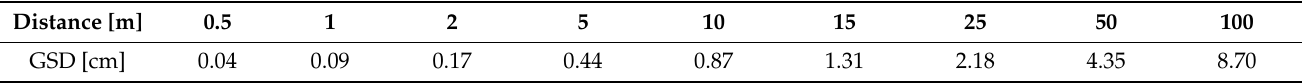
Table 2. Relationship between IFOV and GSD calculated for FLIR VUE PRO thermal camera.